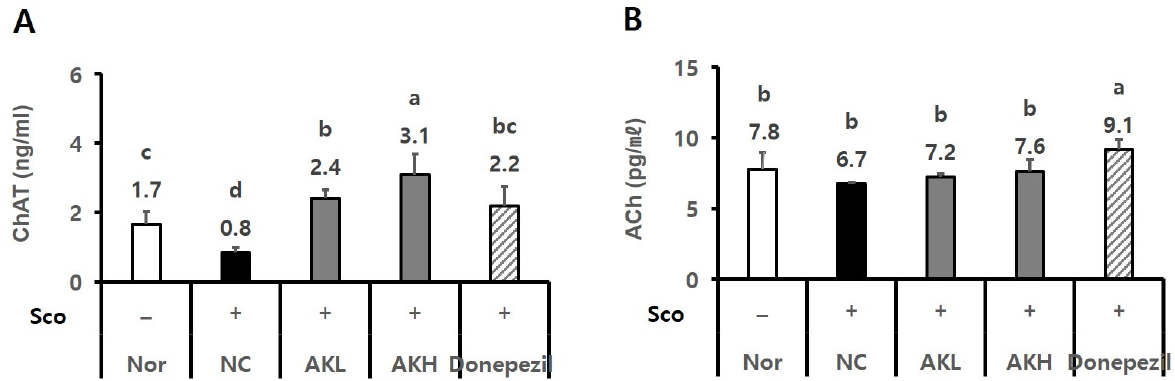
Figure 5. Effects of AK extract on the levels of ( A ) hippocampal ChAT activity and ( B ) serum ACh of rats chronically treated with scopolamine. The rats were randomly divided into five groups, as follows: Nor, normal, commercial diet + saline; NC, negative control, commercial diet + scopolamine in saline; AKL, a commercial diet with AK extract 0.14% + scopolamine in saline; AKH, a commercial diet with AK extract 0.42% + scopolamine in saline; Donepezil, commercial diet + Donepezil 1 mg/kg in saline + scopolamine in saline ( n = 3 for ChAT assay and ACh assay). All rats, except those in the normal group, were intraperitoneally administered 1 mg/kg of scopolamine once daily for 21 days. Food and water were freely accessible. Statistical analysis was performed using SAS software. The values indicated with different letters were found to differ significantly at p < 0.05 by Duncan’s multiple range test.